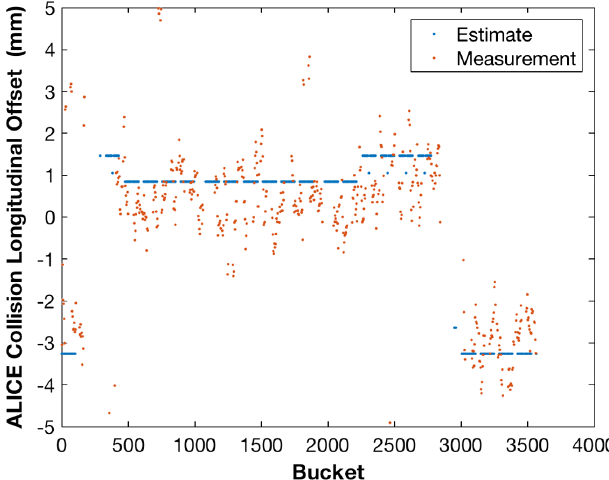
FIG. 25. Collision point longitudinal shift for ALICE. Data and theoretical